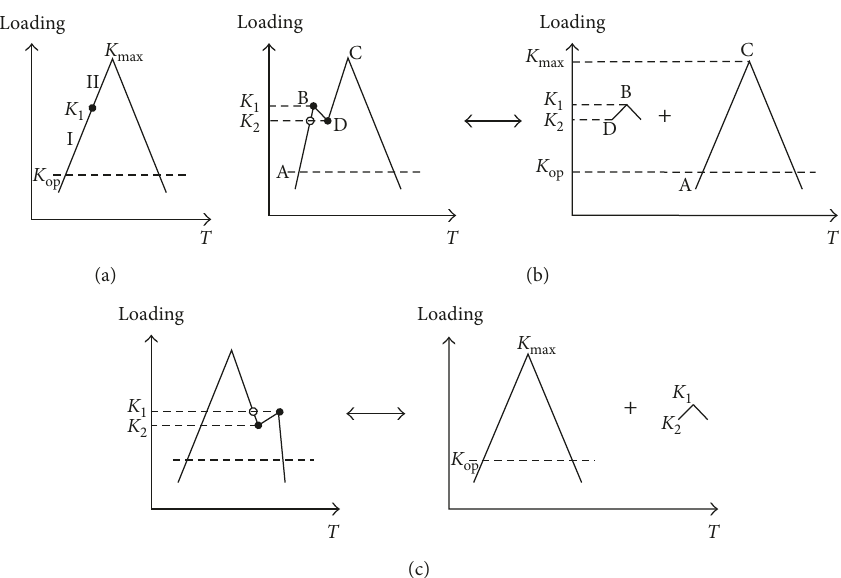
Figure 2: The simplified loading cases. (a) Constant amplitude loading. (b) Superimposed loading condition. (c) Superimposed loading